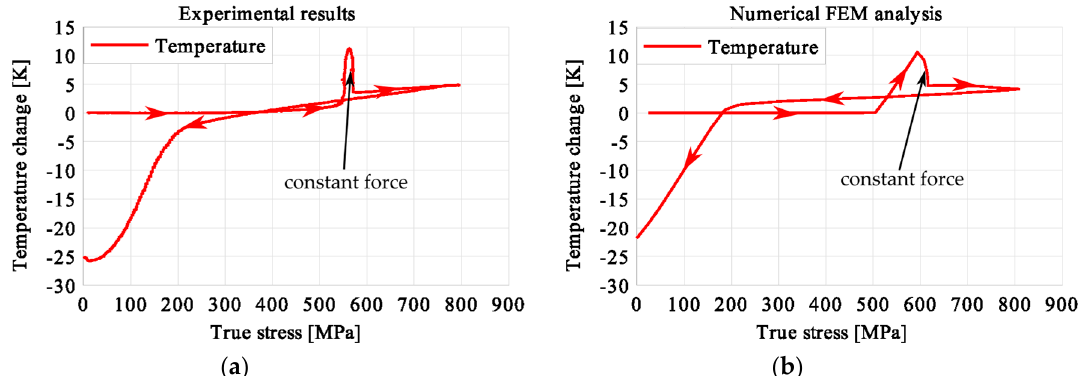
Figure 15. Temperature variations vs. stress for the loading program (2): 3-min loading interruption at the beginning of the LMT: ( a ) experimental; ( b ) numerical results.